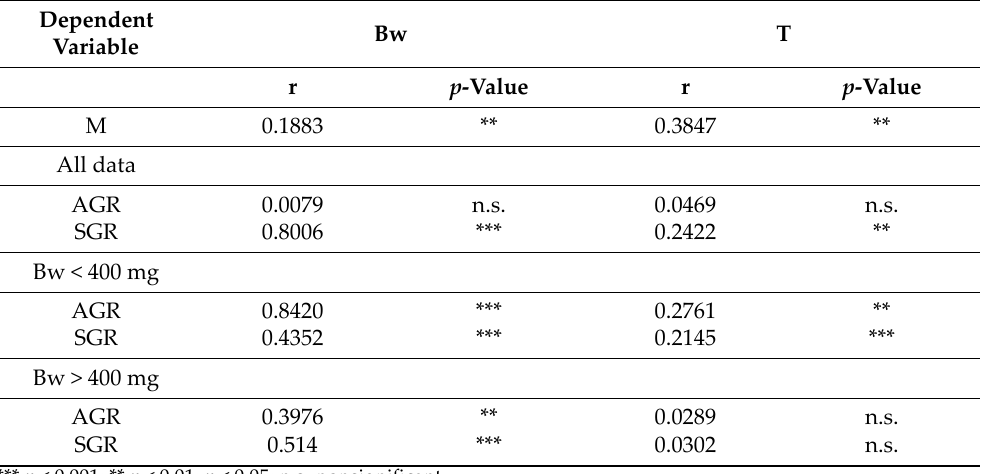
Table 1. Results of Pearson partial correlation test of body weight (Bw) and temperature (T) for mortality (M), absolute growth rate (AGR) and specific growth rate (SGR).